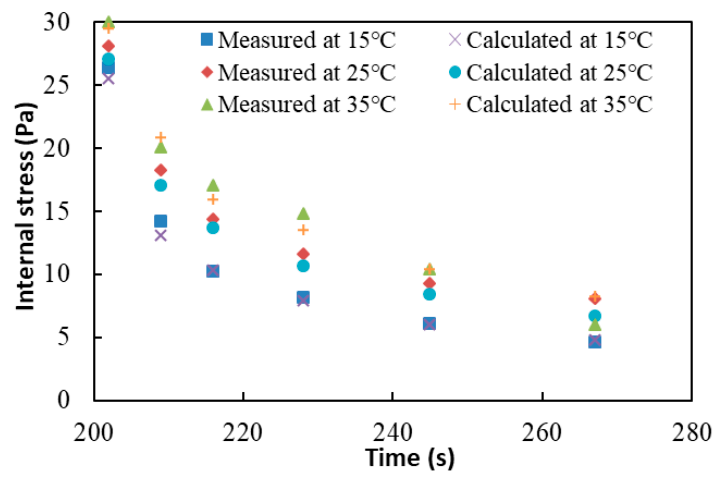
Figure 6. Measured and calculated internal stress of the base binder from a nondestructive CSR test.